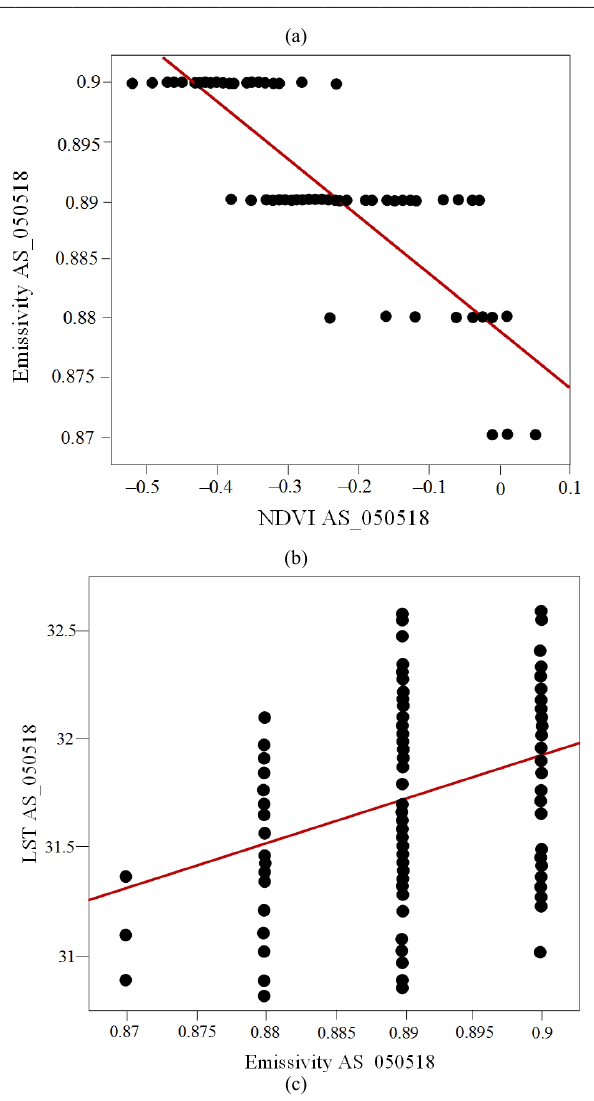
Fig. 11. Regression analysis results of correlation between LST and NDVI of AS area on May 5 (a), emissivity and NDVI of AS area on May 5 (b), LST and emissivity of AS area on May 5